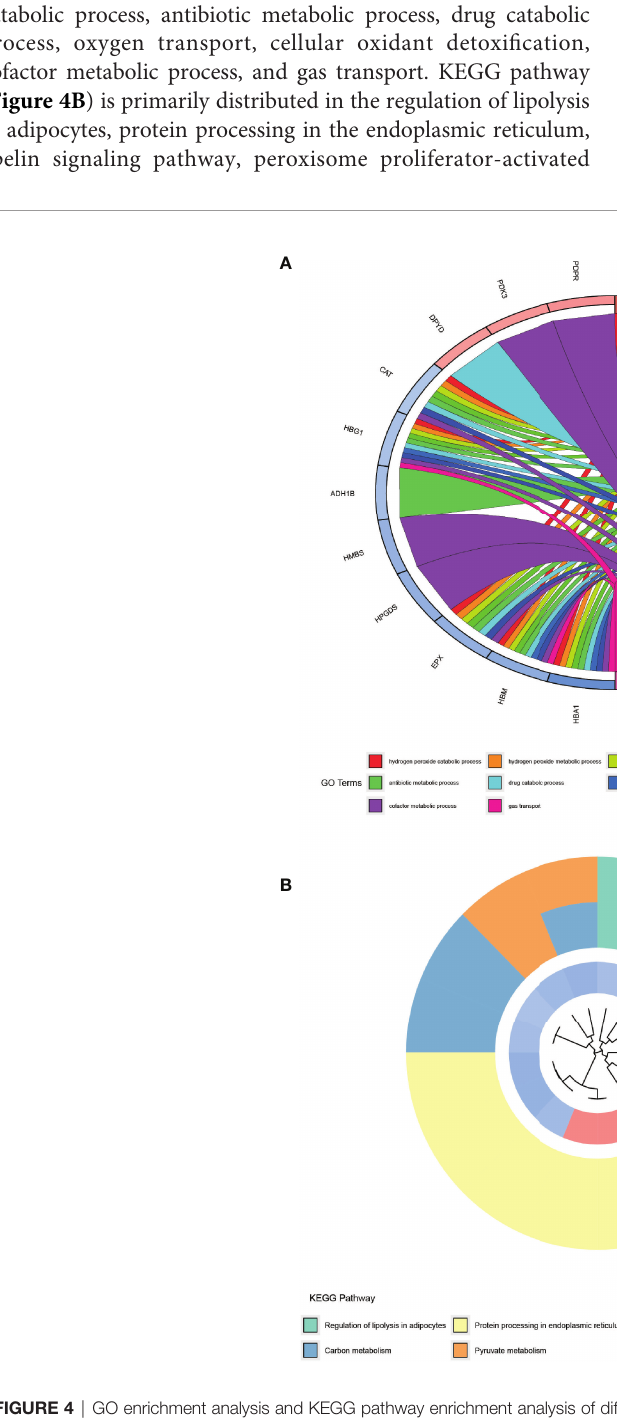
FIGURE 4 | GO enrichment analysis and KEGG pathway enrichment analysis of differentially expressed proteins. (A) shows the top 10 entries of GO enrichment analysis for differentially expressed proteins. (B) shows the KEGG pathway enriched by the differentially expressed